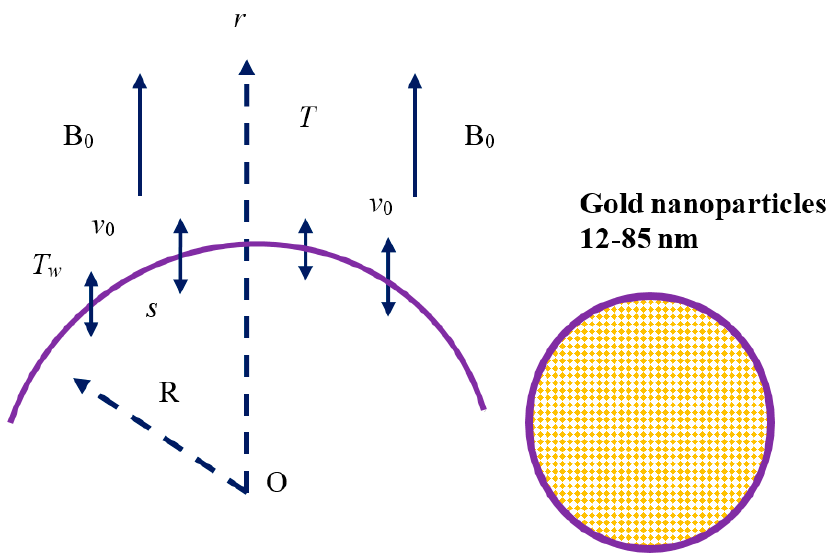
Figure 1. Physical diagram of the problem.